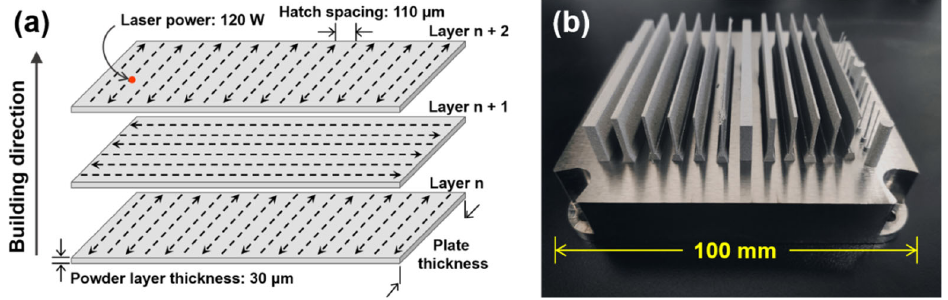
Figure 1. ( a ) Illustration of the orthogonal-type laser scanning strategy; ( b ) the NiTi plate samples were fabricated by SLM.